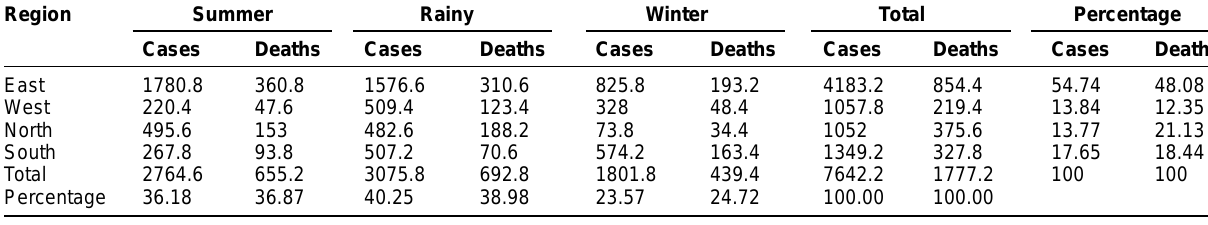
Table-3. Region and season wise average number of cases and deaths in sheep and goats Region